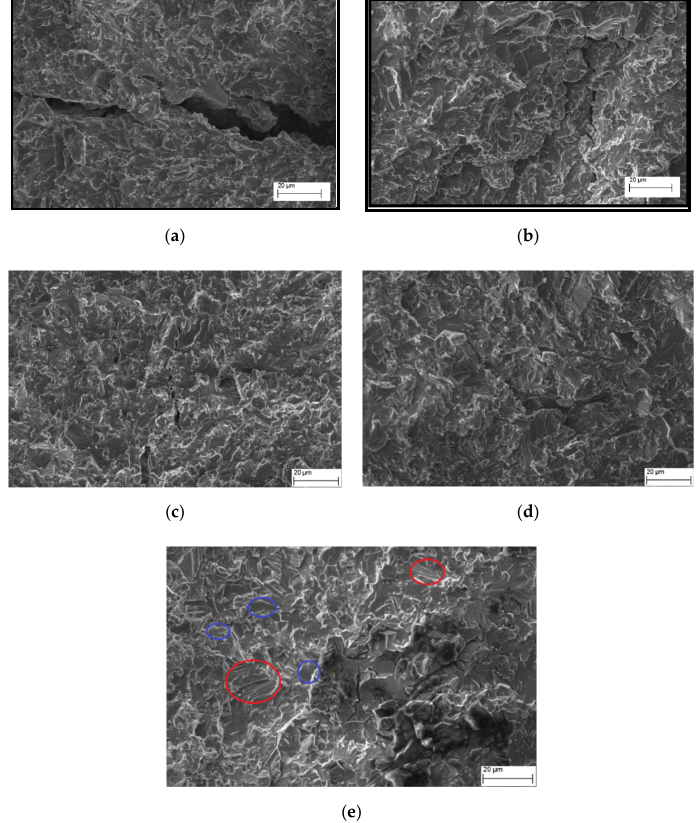
Figure 5. Fractography images of ( a ) Ti-48Al-2Cr-2Nb + 0% Mn, ( b ) Ti-48Al-2Cr-2Nb + 2.5% Mn, ( c ) Ti-48Al-2Cr-2Nb + 5% Mn, ( d ) Ti-48Al-2Cr-2Nb + 7.5% Mn, and ( e ) Ti-48Al-2Cr-2Nb + 2.5% Mn. Inter-lamellar surface and trans-lamellar surface inside the blue and red color circles, respectively.